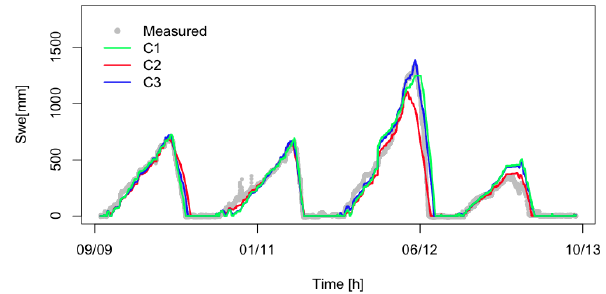
Table 7. Goodness of fit values for the calibration (top) and eval- uation periods (bottom) for the site-specific calibrations at the Joe Wright station and for the models C1, C2 and C3 at an hourly